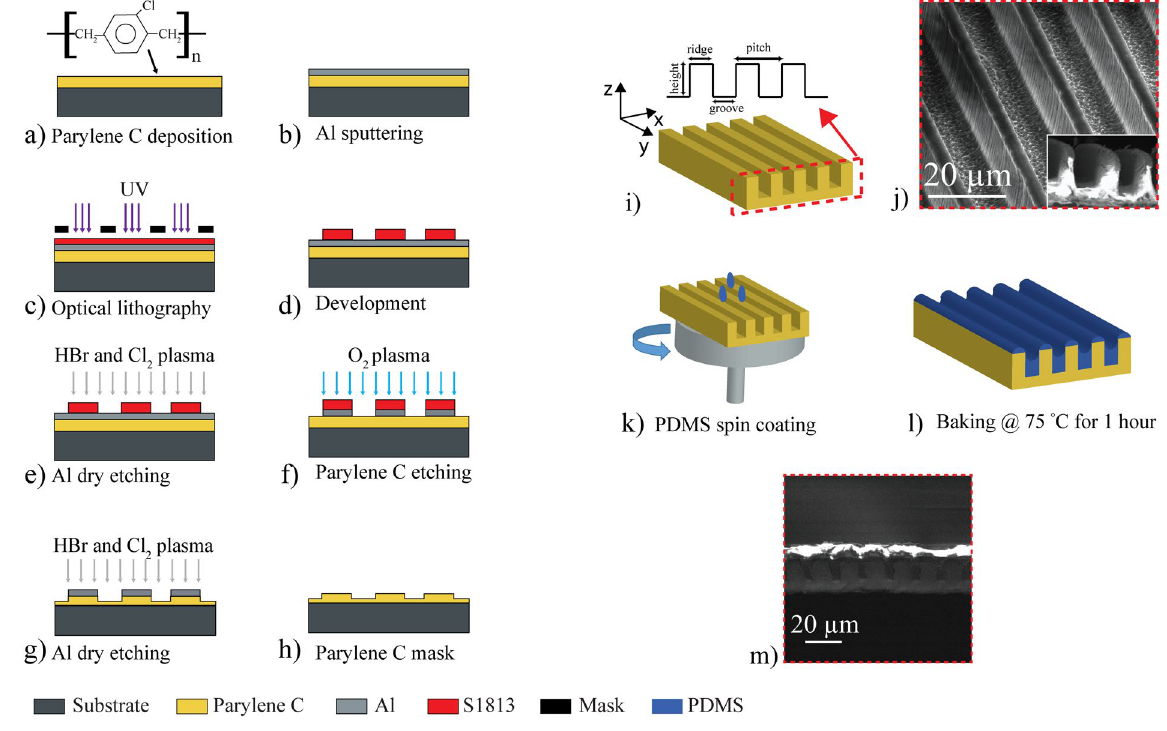
Figure 1. Schematic of the microfabrication process of Parylene C/PDMS hybrid constructs. Microfabrication procedure to obtain high aspect ratio Parylene C grooves ( a – i ). A sketch of Parylene C with cross section (dash red line) and the characteristic features (height, ridge, groove and pitch) is illustrated in ( i ). In ( j ) a representative SEM image of only Parylene C is shown. PDMS was spin coated ( k ) and baked at 75 °C for 1 h ( l ). The cross section of the bilayer is shown in the SEM image ( m